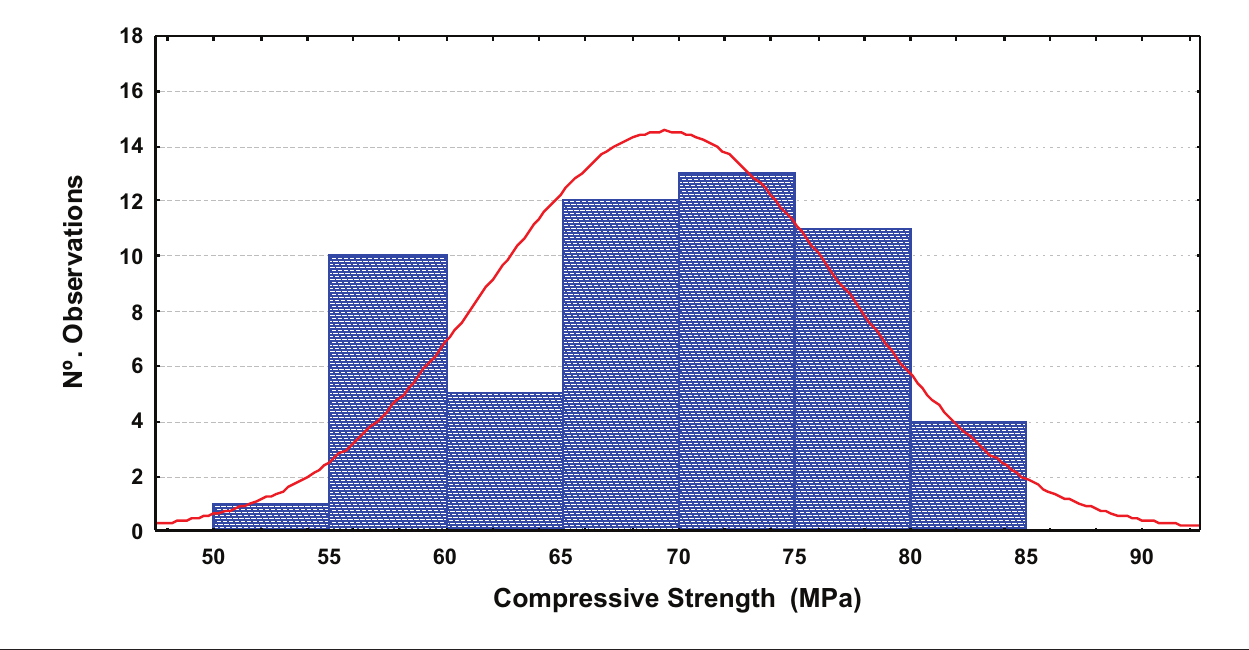
Figure 5 – Histogram of the compressive strength results obtained from concrete class C60